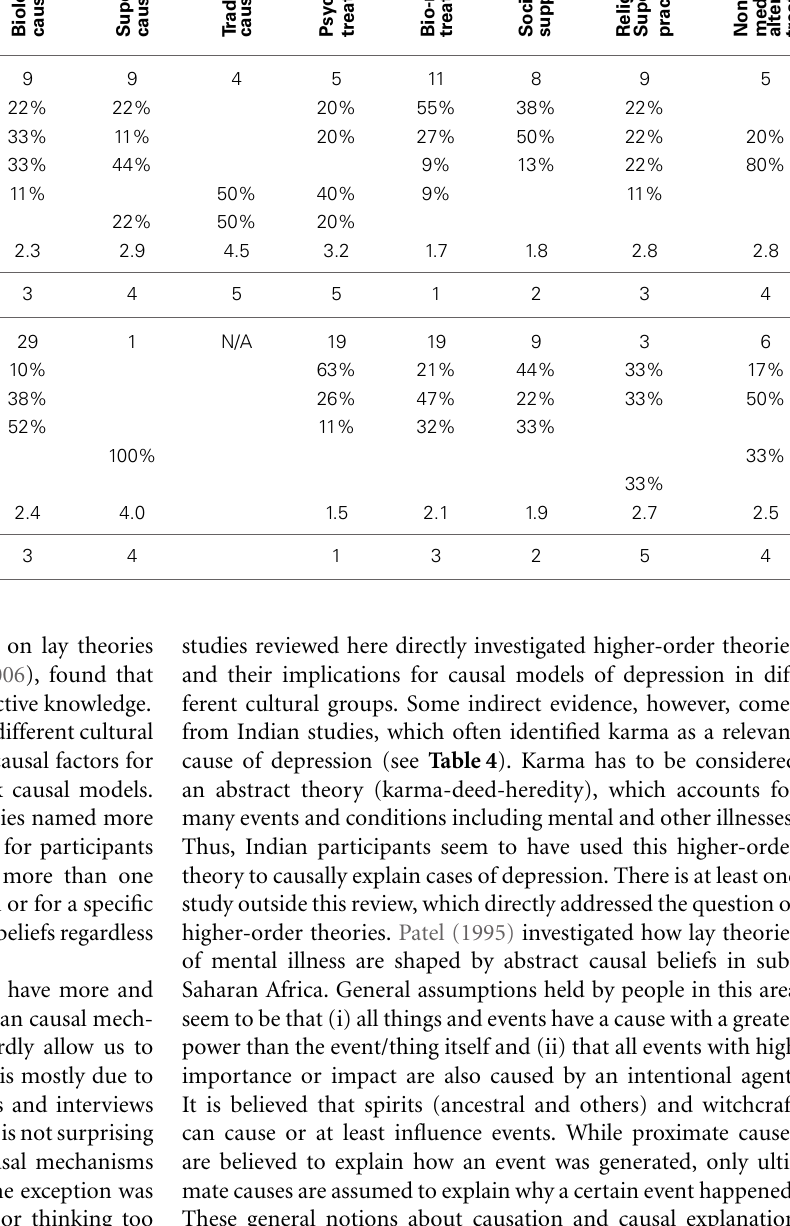
Table 5 | Analysis of rank orders of assumed causes and preferred treatments in non-Western and Western cultural groups. Causes Treatments